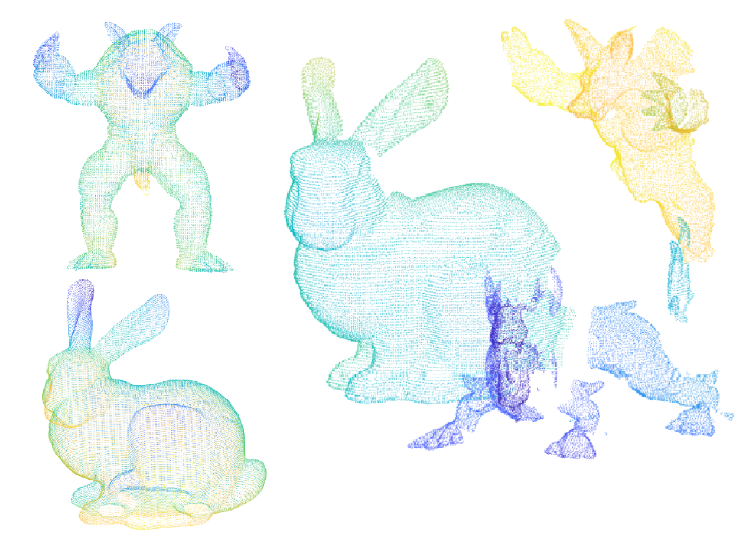
Figure 7. Part of the point cloud in Random